Question: From the figure, is the trend upward or downward?
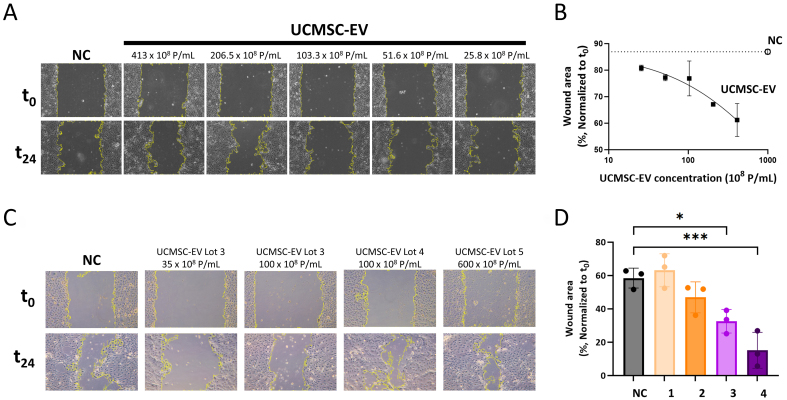
Answer: increasing